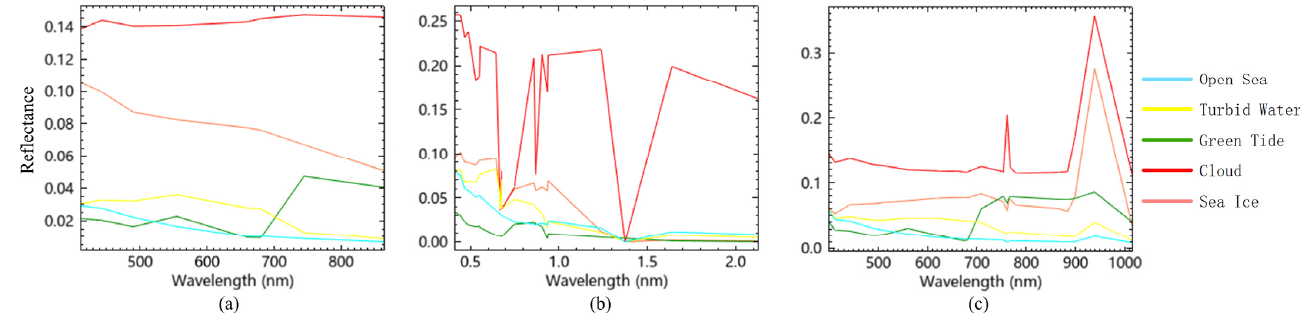
Figure 6. Spectral information of the endmembers of the ocean coverage object: ( a ) GOCI, ( b ) MODIS and ( c ) OLCI.